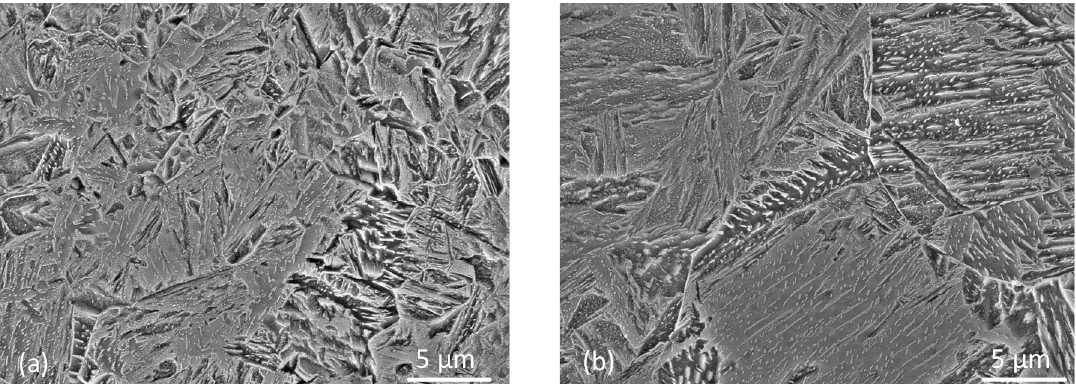
Figure 9. Chemically etched microstructure at the inner boundary of nominal CHD (= 0.4 mm) for (a) as-built state ( a ) and grain-coarsening heat treatment before case hardening ( b ), magnification x10.000. Used additive manufacturing parameters: P L = 300 W; H = 40 µm, h = 120 µm, v s = 850 mm/s.